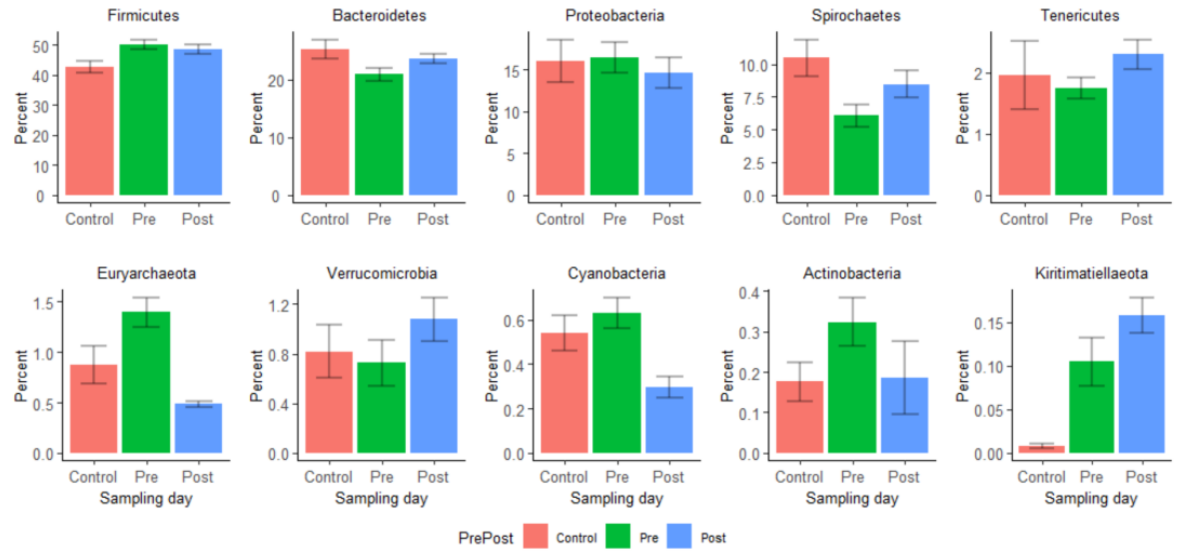
Figure 4. The relative abundance of the ten most frequent phyla was compared between pre- and post-treatment and control samples.